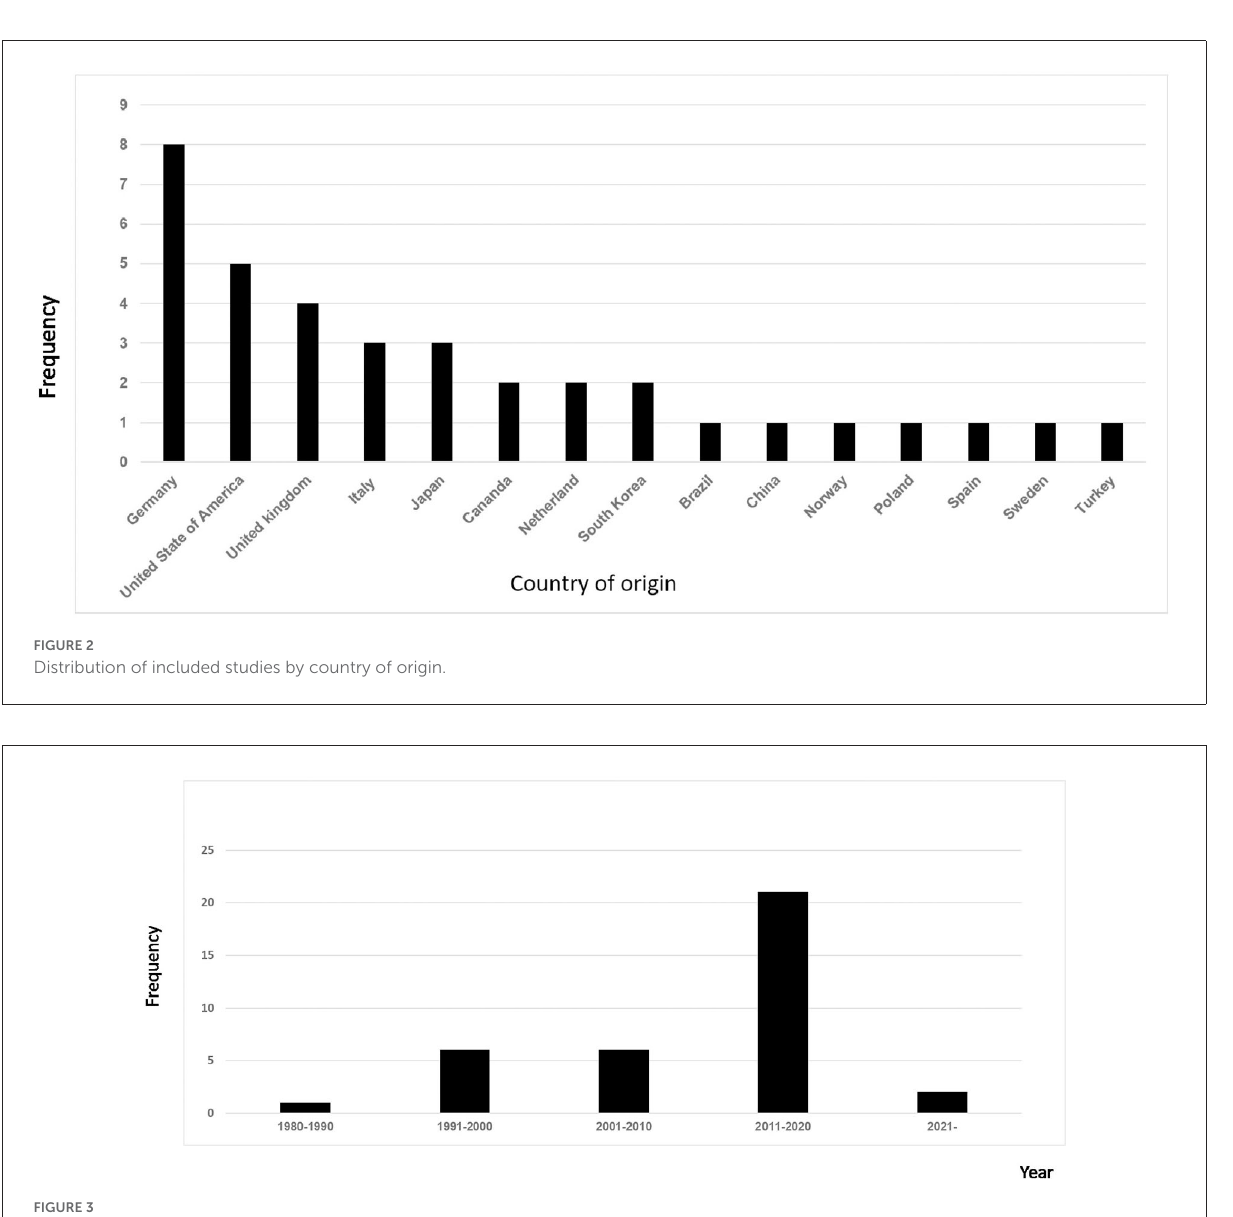
FIGURE3 Distribution of included studies by